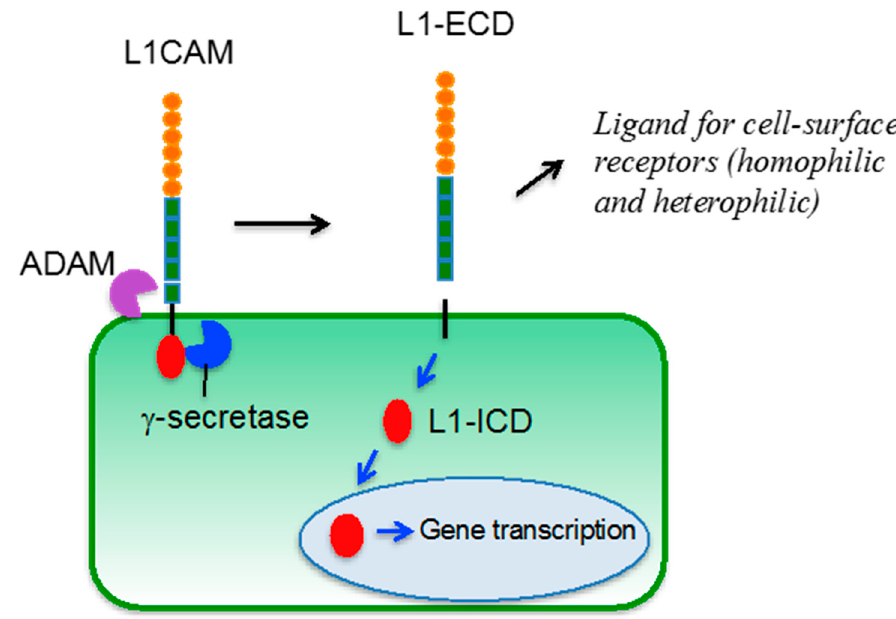
Figure 3. L1CAM processing at the plasma membrane. At the plasma membrane L1CAM undergoes proteolytic cleavage of the ectodomain mediated by a disintegrin and metalloproteinases (ADAM, purple object) which results in the shedding of a biologically active L1CAM extracellular domain (L1-ECD). Black arrows indicate the cleavage and release of L1-ECD. The membrane-associated portion becomes a substrate for γ -secretase (blue object) that cleaves the intra-membrane portion of L1CAM and induces the release of the intracellular domain of the protein (L1-ICD, red object). L1-ICD translocates into the nucleus and regulates gene transcription (blue arrows).